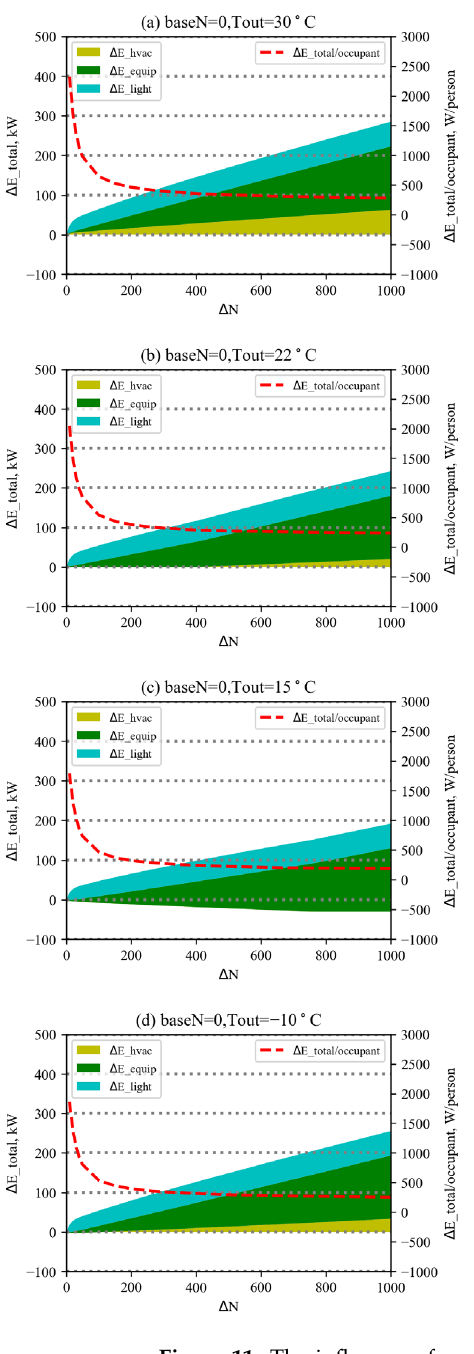
Figure 10. The influence of occupancy on the change in total energy consumption with different baseN and T out (constant fresh air volume).